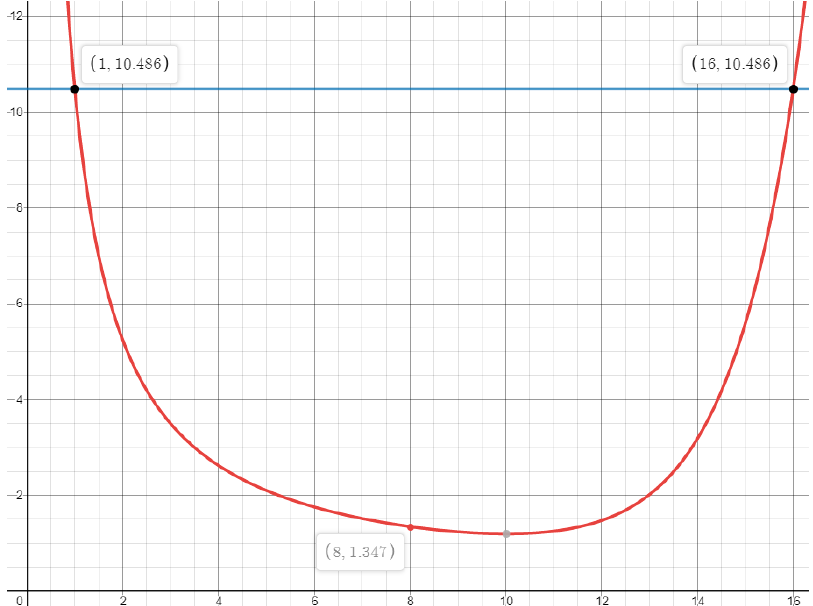
Figure 7. Delay bound of the proposed framework (the red curve) with p = 2, E = 16, F = 2 16 = 65536, r = 1 Gbps, L = 10 Kbit, with varying h. When h = 8, the delay bound is 1.347 s. When h = 1 and h = 16, it is 10.486 s, which is identical to the delay bound given with IntServ. The delay bound of the ATS framework is 20.97 s. The red curve reaches the minimum near h = 10. The possible sets of parameters are {h = 1, d = 16, n = 32768 = 2 15 }, {h = 2, d = 8, n = 2 14 }, {h = 4, d = 4, n=2 12 }, …, {h = 8, d = 2, n = 2 8 }, {h = 16, d = 1, n = 1}. Note that if h = 16, then n = 1, and the case becomes identical to an IntServ framework. With h = 16, the total delay of IntServ is identical to that of the proposed framework, indeed. Also note that h = 1 gives the same bound. Note that all the possible choices of h and d give smaller than or equal delay bounds than that of IntServ. They are always smaller than that of ATS. The optimal choice in this case is {h = 8, d = 2}, which gives 1.347 s of delay bound, which is almost 8 times better than IntServ, and 16 times better than ATS. This result is remarkable. By only diving a path into two parts, put a minima IR in the path, and aggregating flows accordingly, we can reduce the delay bound as much as to 1/8, compared to the IntServ. The scheduler complexity is reduced in the order of 2 8 . Next, consider a network with p = 8, E = 4, F = 8 4 = 4096, r = 1 Gbps, L = 10 Kbit. This set of parameters represents a smaller sized network with nodes with more ports. The RHS (right hand side) of Equation (11) gives the red curve in Figure 8. The blue line represents the value of the RHS of (10), IntServ, which is 0.164. The value of the RHS of (12), the delay bound of ATS, is not shown, which is 0.328.